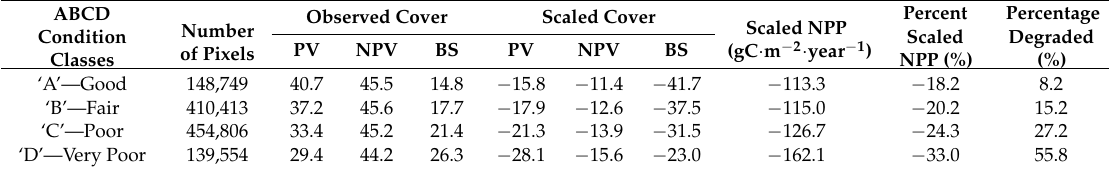
Table 6. Comparison of ABCD condition, from Karfs et al. [43], with scaled NPP and scaled fractional cover for the entire BDT region.